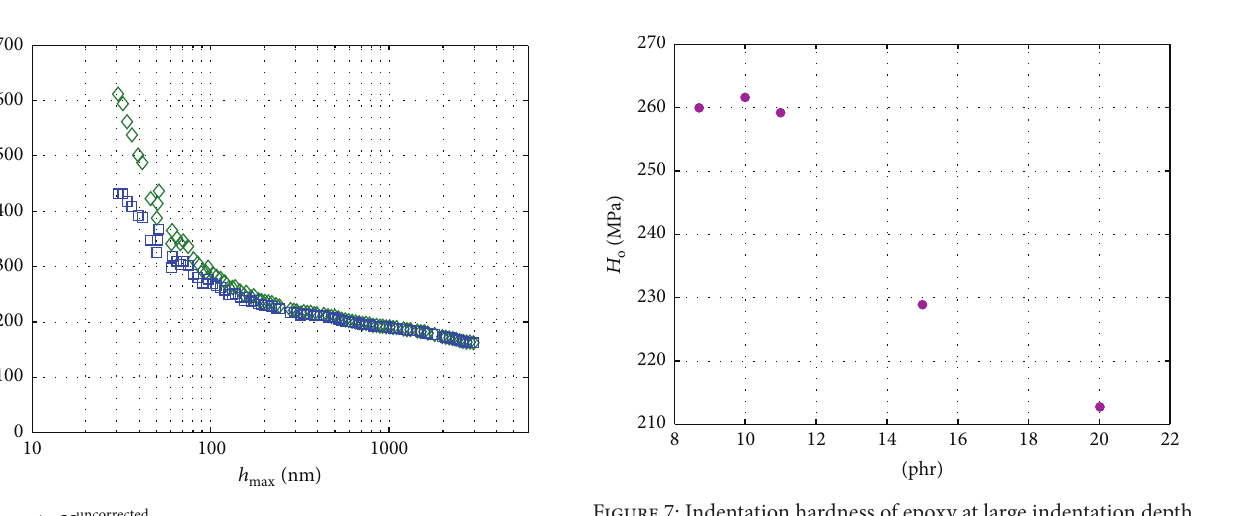
Figure 7: Indentation hardness of epoxy at large indentation depth ℎ max as a function of hardener percentage [23].